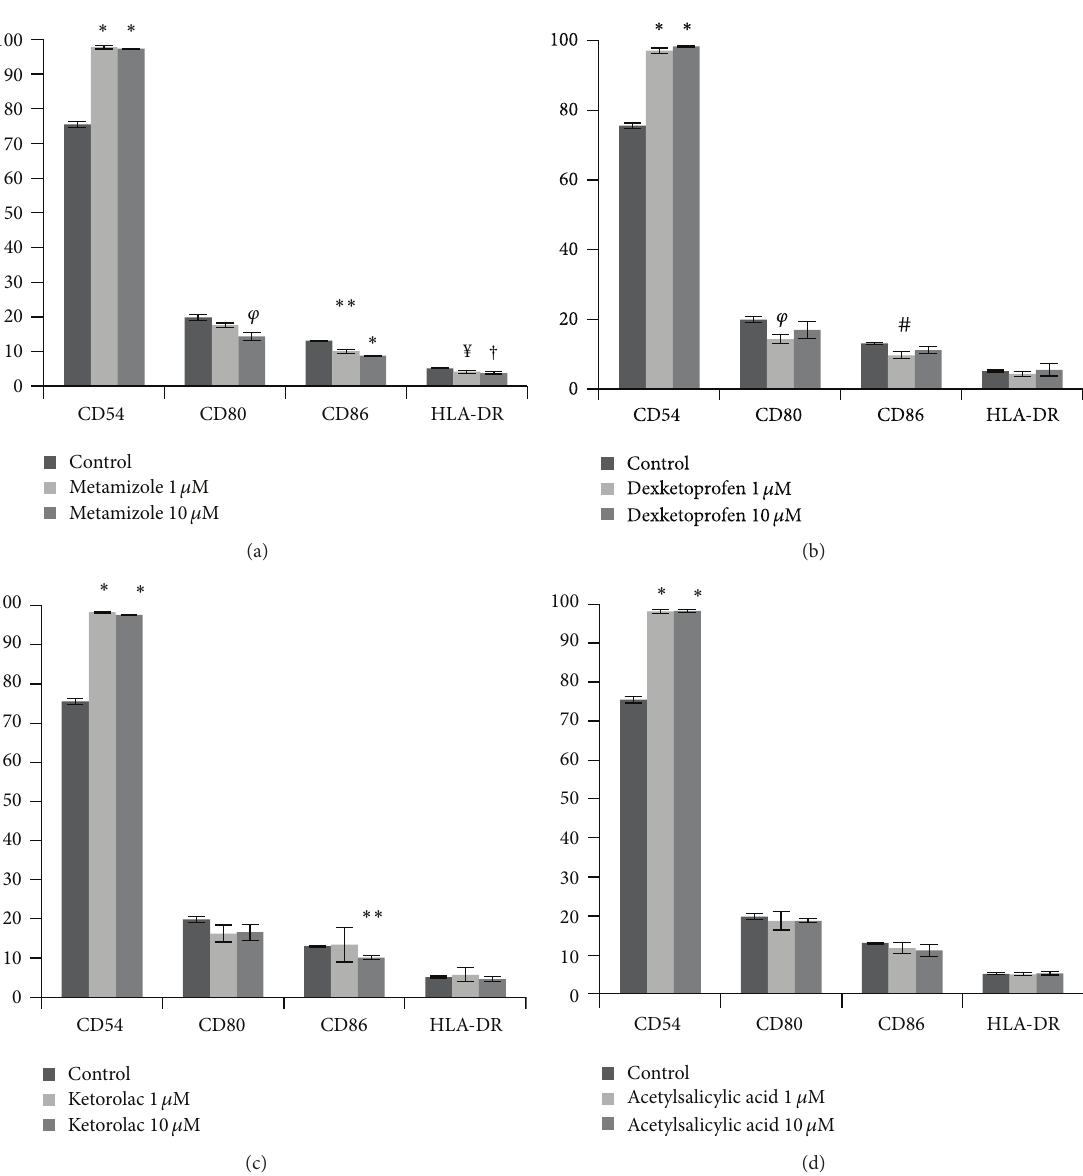
Figure 1: Percentage of expression of different surfaces markers of the osteoblast (MG-63), treated for 24 h with doses of 1 and 10 𝜇 M of (a) metamizole, (b) dexketoprofen, (c) ketorolac, and (d) acetylsalicylic acid. ∗ 𝑃 < 0.01 ; ∗∗ 𝑃 = 0.001 ; 𝜑 𝑃 = 0.003 ; # 𝑃 = 0.005 ; † 𝑃 = 0.006 ; ¥ 𝑃 = 0.03 ; ‡ 𝑃 = 0.018